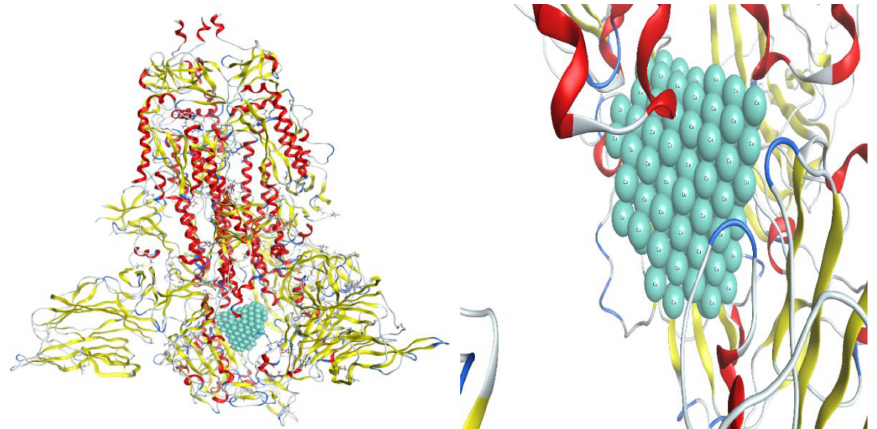
Figure 6. Scheme of the molecular docking involving the conical Cu NPs and the target spike glycoprotein (PDB ID: 6ZGG), together with the pharmacophore. Reprinted from Journal of Molecular Structure , Vol 1253, Aallaei et al. Investigation of Cu metal nanoparticles with different morphologies to inhibit SARS-CoV-2 main protease and spike glycoprotein using Molecular Docking and Dynamics Simulation, Art. N. 132301, Copyright (2022) [102], with permission from